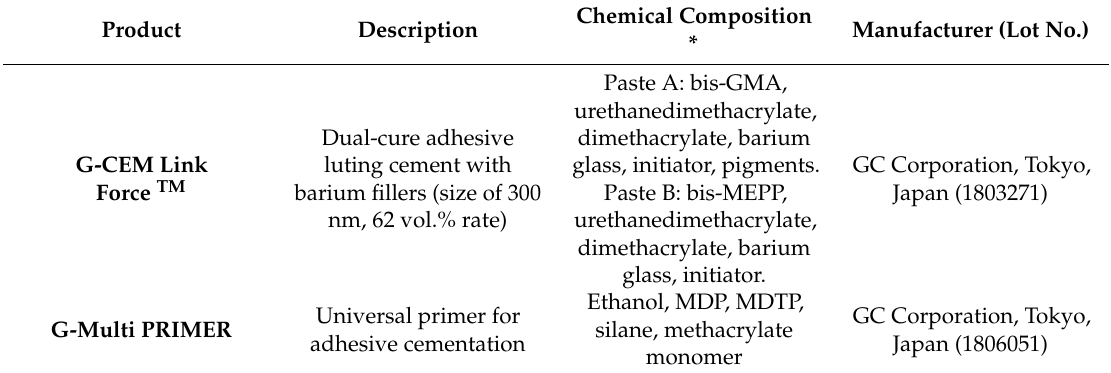
Figure 2. Phases of the specimen preparation: ( a ) application of primer; ( b ) application of adhesive resin cement; ( c ) specimen prepared. Table 2. Characteristics of the cementation system tested in this study, according to data published by manufacturers.